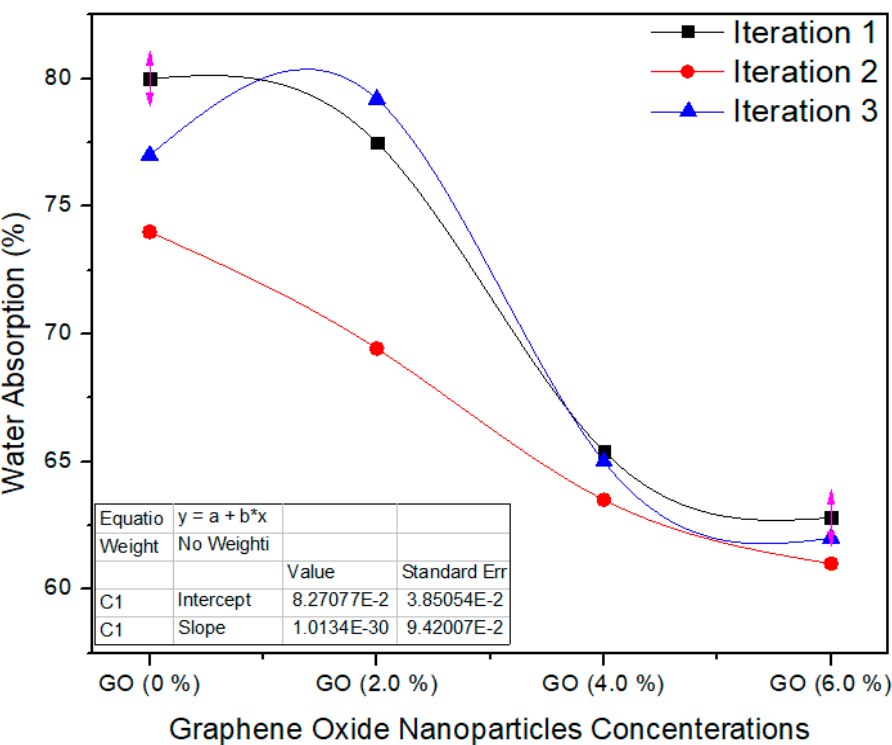
Figure 10. Water absorption property of the final nano MDF with several counts of GO.